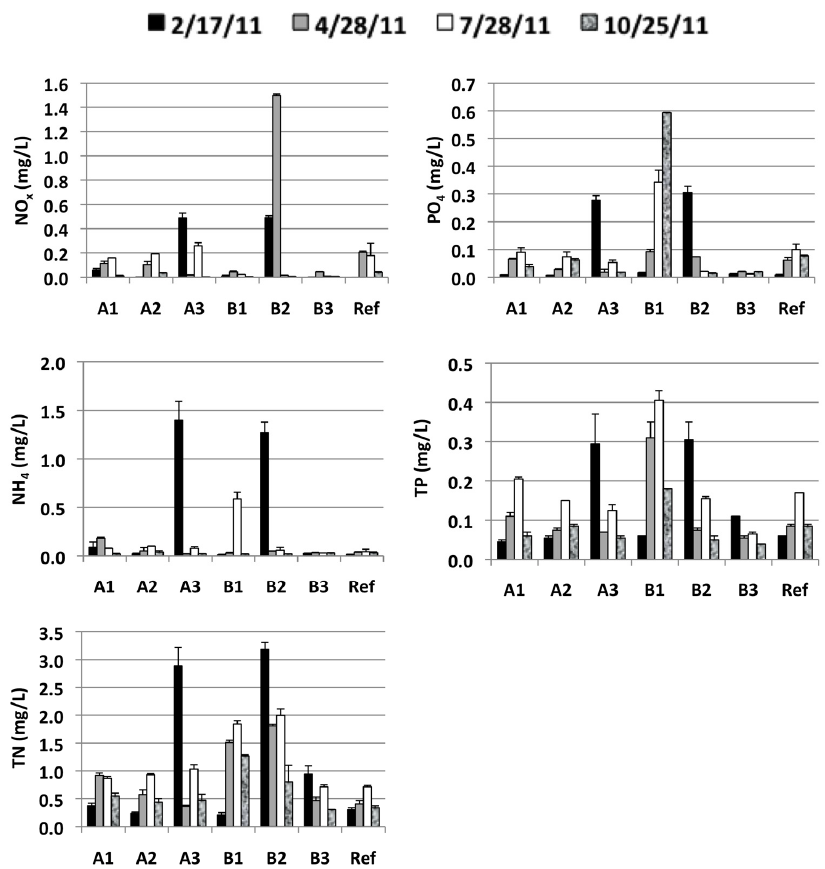
Figure 2. Nitrate + Nitrite (NO x -N), ammonium (NH 4 -N), total nitrogen (TN), phosphate (PO 4 -P), total phosphorus (TP), and total suspended solids (TSS) at the CWU sampling stations. Error bars represent standard error of the mean.